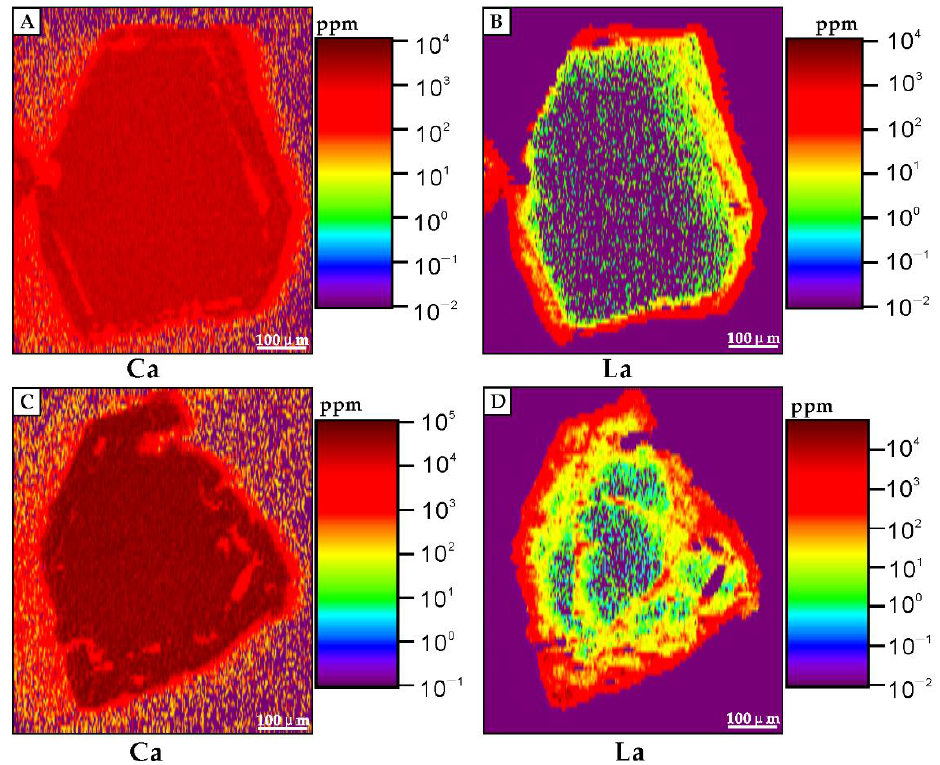
Figure 3. Mapping analyses result after water – mineral reaction (FAp-La solution). ( A , B ): location of La-4 grain 3, ( C , D ): location of La-12 grain3.